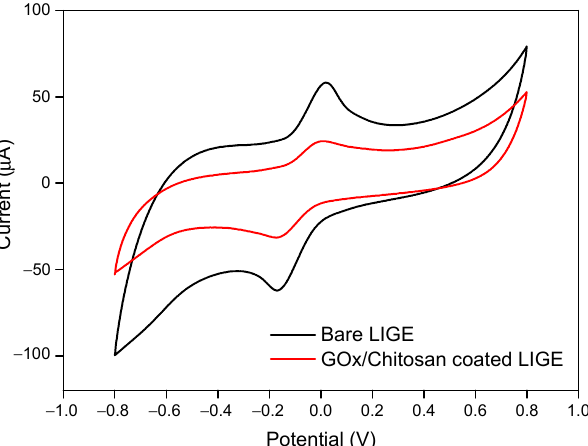
Figure 4. Cyclic voltammograms on bare LIGE and GOx/chitosan-modified LIGE in the presence of 2 mM potassium ferricyanide. 2 mM potassium